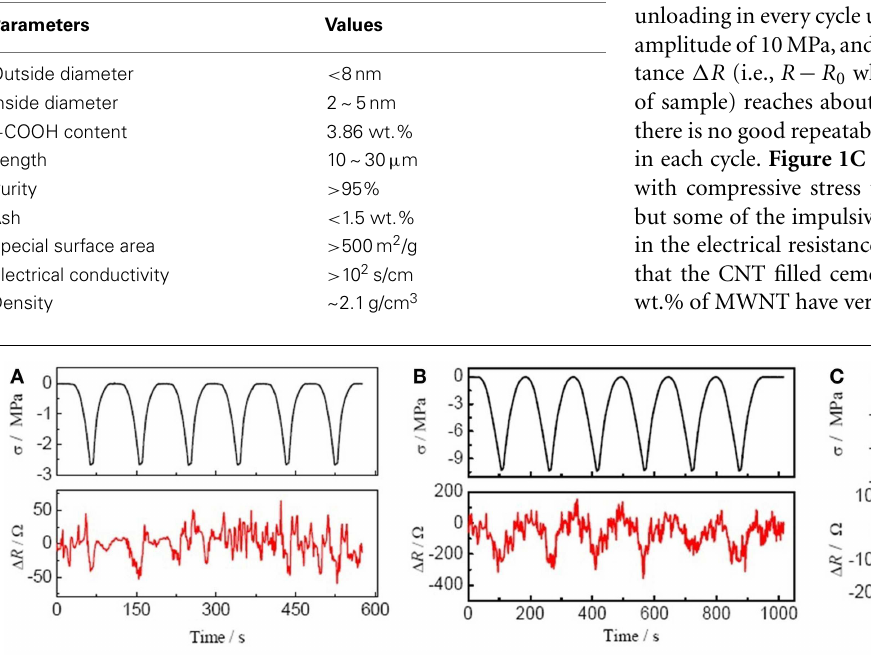
FIGURE 1 | Pressure-sensitivity of CNT filled cement mortar composites with SDS and 1 wt.% of MWNT . (A) Under repeated compressive loading with amplitude of 2.5MPa. (B) Under repeated compressive loading with amplitude of 10MPa. (C) Under impulsive